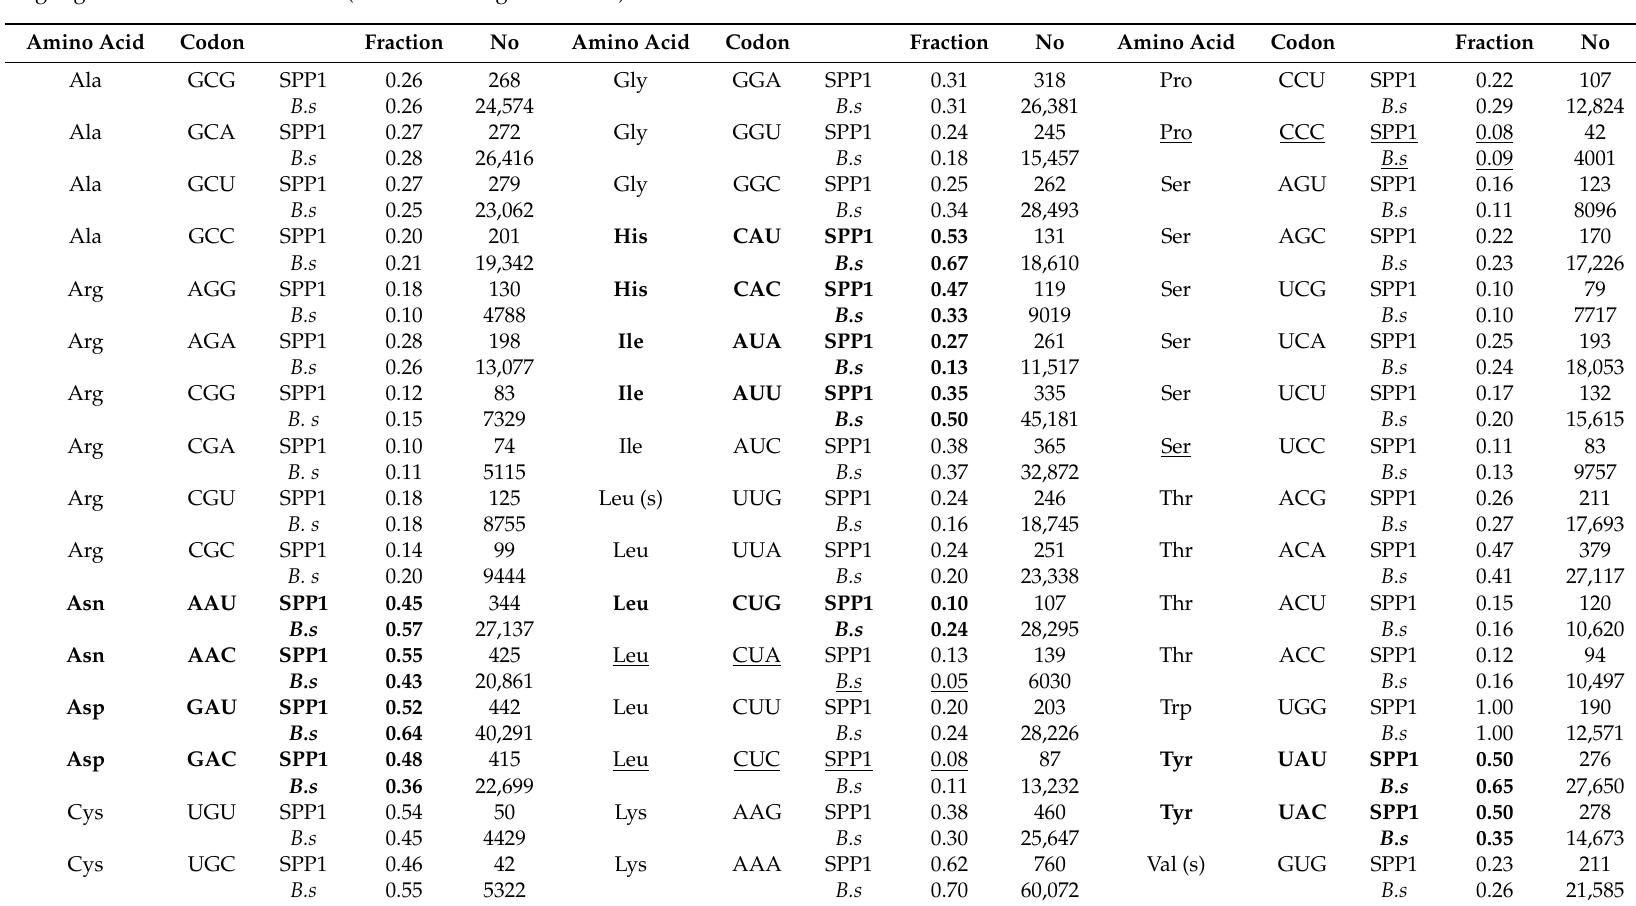
Table 4. Codon usage bias in SPP1 and B. subtilis . The total number of codons (No) used in the complete set of ORFs of SPP1 (this work) or B. subtilis [47,48] and the fraction of each codon used to code a specific amino acid are listed. When the fraction value differs by more than 0.1 this variation of codon usage frequency is highlighted in bold. Rare codons (fraction of usage below 0.1) are